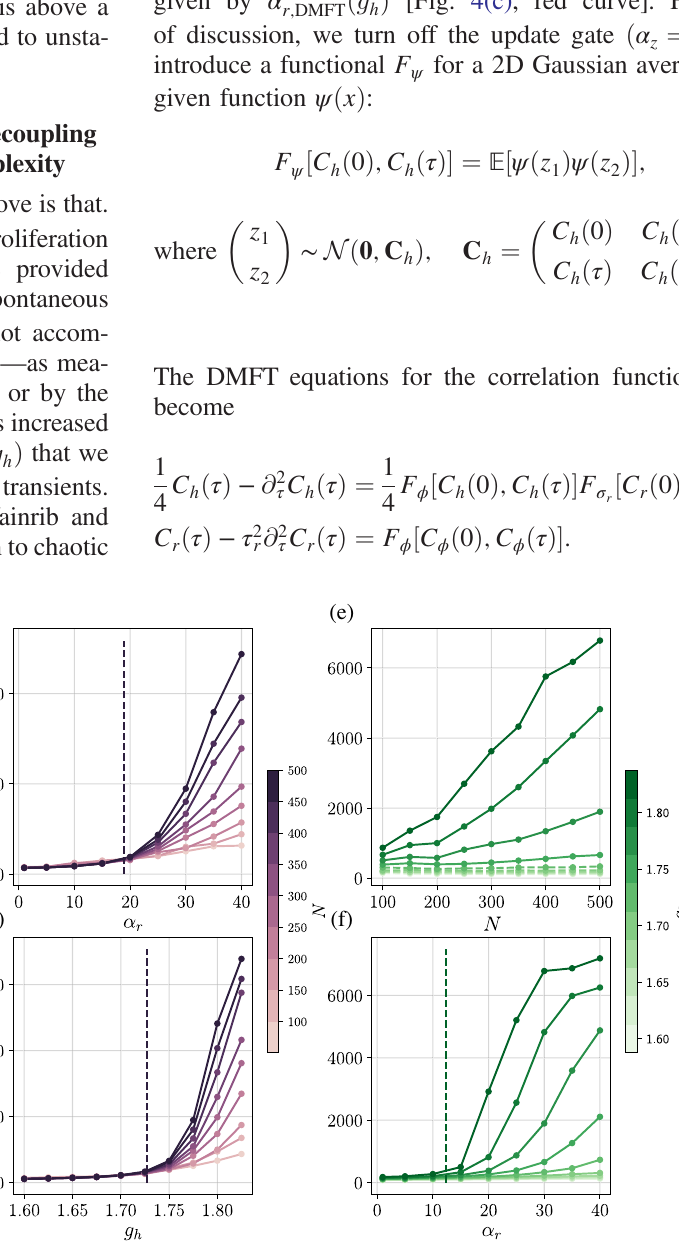
FIG. 11. Transient times at the bifurcation transition. Transient times ( τ Dashed plot lines correspond to situations where α 1 . 775 and (b) τ g vs g for N ¼ 500 ; the dashed line indicates g h ¼ T h dashed vertical line is α (cid:3) ð 1 . 775 Þ . (d) τ T vs g h for α r ¼ 30 ; the dashed line is g h such that α (cid:3) r; DMFT dashed plot lines correspond to situations where 30 < α (cid:3) Transient times are averaged over 2000 instances of random